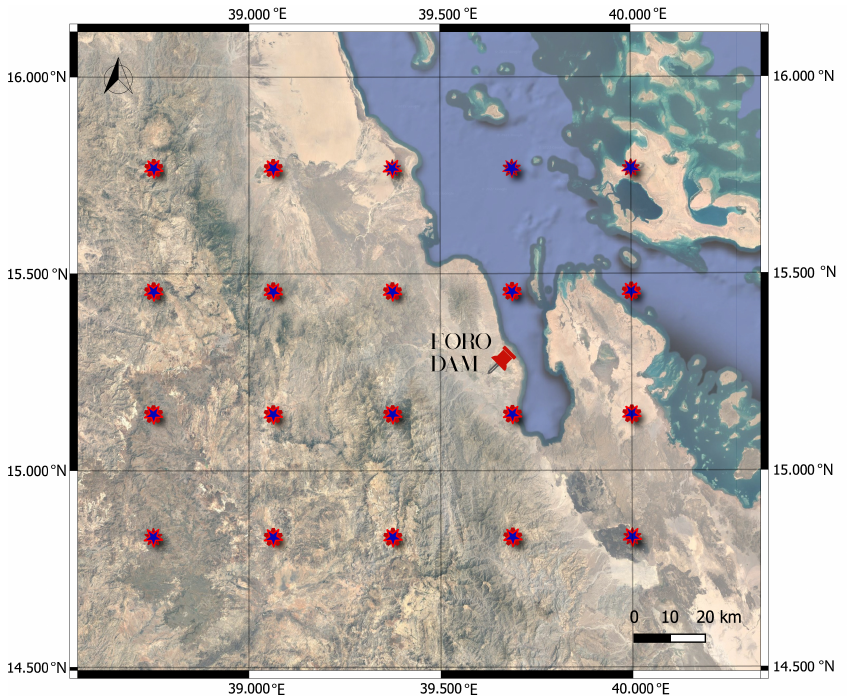
Figure 5. Locations associated with climate data (blue–red markers) provided by NCEP [29] within the area of